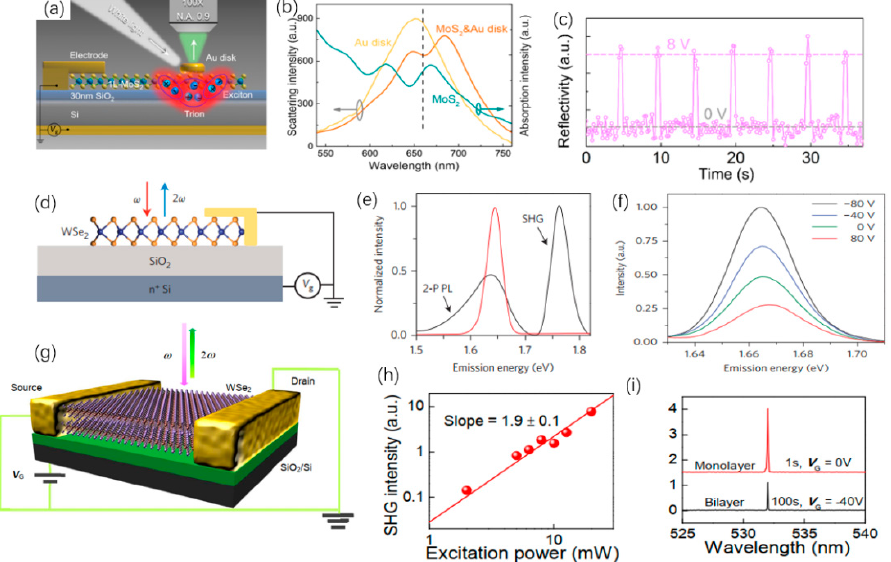
Figure 14. ( a ) Structure schematic diagram of Au/MoS 2 . ( b ) The scattering spectrum curve of gold dish and Au/ MoS 2 , and the absorption spectrum curve of MoS 2 . ( c ) Modulator switching time under an applied voltage with a period of 1 ms [279]. ( d ) Schematic diagram of WSe 2 used as an electro-optic modulator. ( e ) The intensity curves of SGH and two-photo induced photoluminescence at different emission energy. ( f ) SGH spectrum curve under different gate voltage [280]. ( g ) Schematic diagram of double-layer WSe 2 used in field effect transistors. ( h ) The relationship between incident light power and CHISHG intensity. ( i ) In the same experimental environment, the SHG intensity comparison chart of signal-layer WSe 2 and double-layer WSe 2 [281].